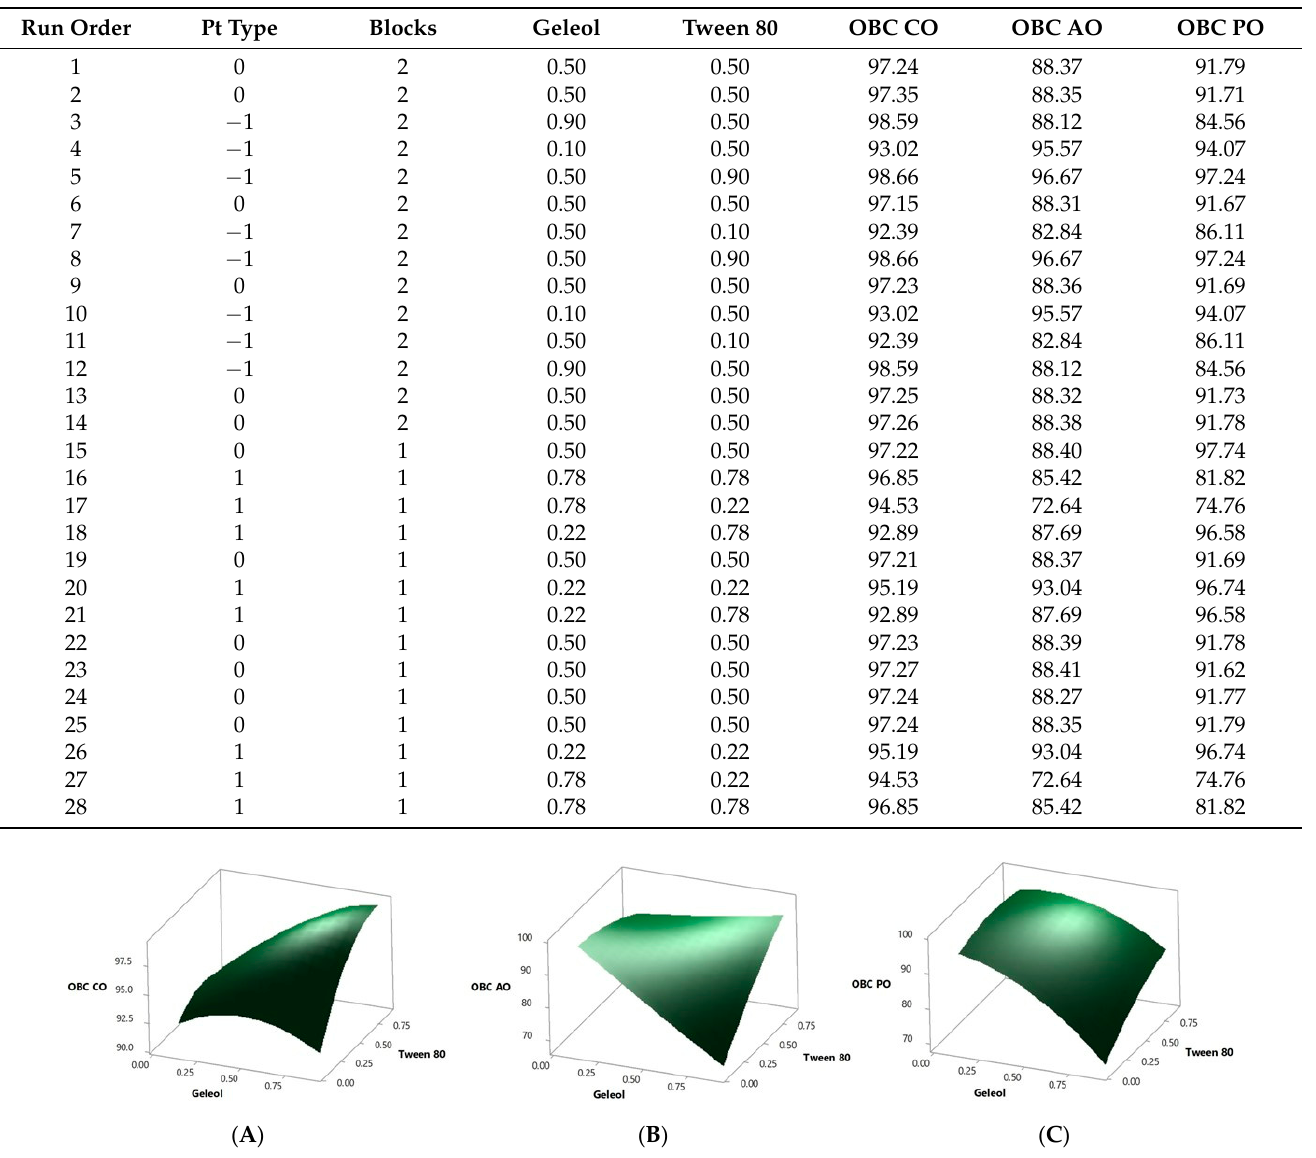
Table 1. Experimental design for Geleol and Tween 80 levels and the results obtained for oil binding capacity concerning the three oils (CO-coconut oil, AO-avocado oil, and PO-pomegranate oil).